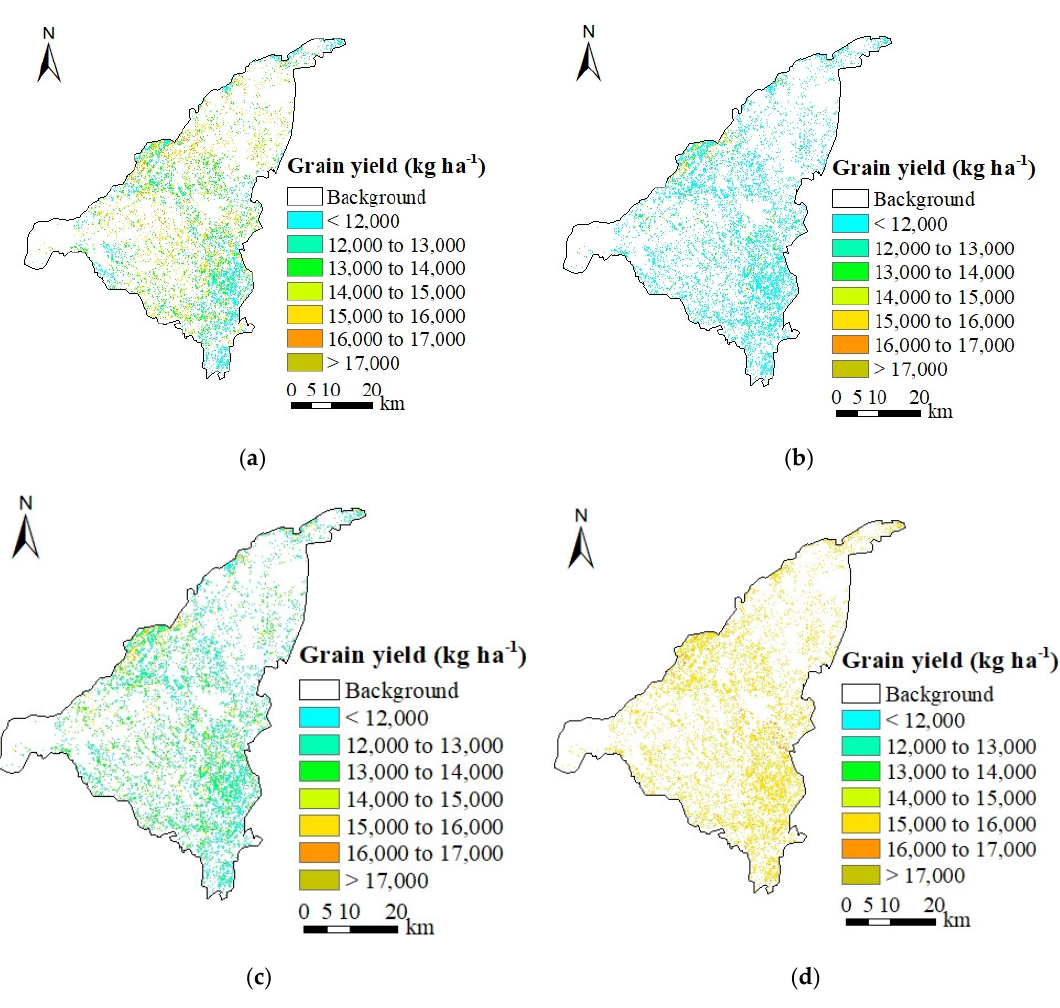
Figure 18. Forecasting results of grain yield in the Jiefangzha sub-irrigation district using the 2019 calibrated model based on the field observations in four different days: ( a ) 2016/7/4; ( b )2016/7/21; ( c ) 2016/8/4; ( d ) 2016/8/26. Table 7. Comparisons between the forecasted grain yields in the Jiefangzha sub-irrigation district based on field observation in different days and the measurements 1 .